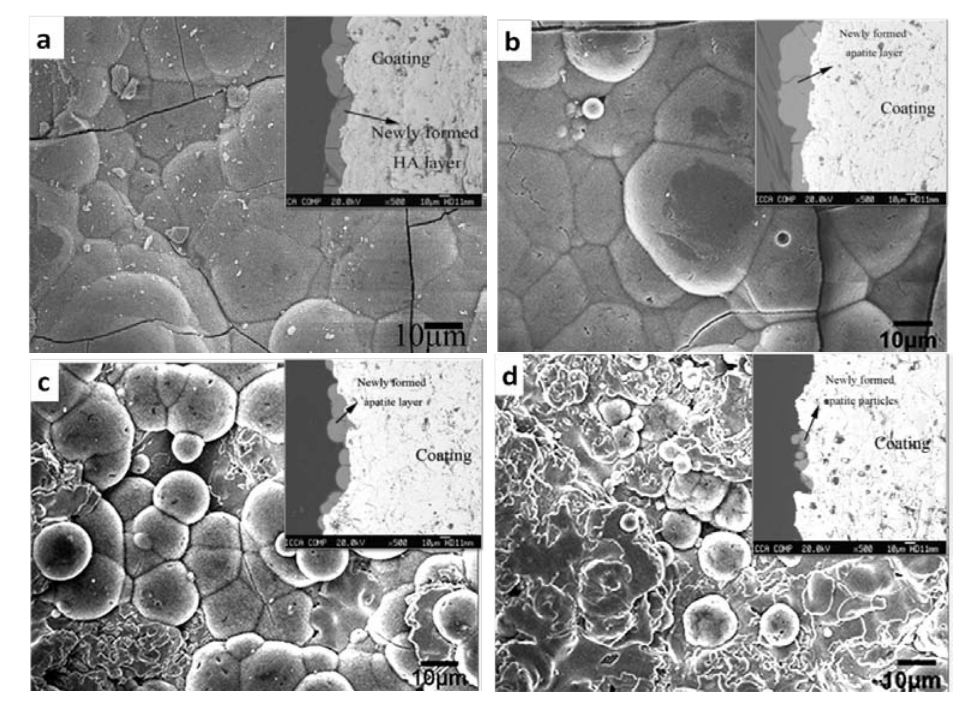
Figure 4 . Comparison of bone-like apatite formation on plasma sprayed zirconia coatings after immersed in SBF solution for 28 days. (a) undoped zirconia coating. (b) zirconia coating stabilized 12.8 mol % calcia. (c) zirconia coating stabilized with 16 mol % calcia. (d) zirconia coating stabilized with 30 mol %